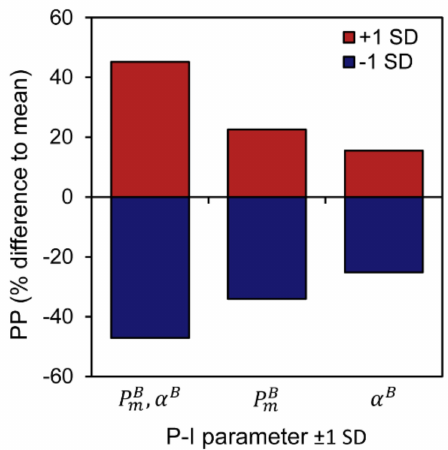
Figure 5. Percentage change in global annual primary production (PP) compared with estimates based on mean photosynthesis versus irradiance (P-I) parameters. Results from three different sensitivity analyses are given: (1) both the initial slope ( α B ) and assimilation number ( P B m ) of the P-I curve were adjusted by 1 standard deviation (SD) [ P B m , α B ]; (2) only P B m was adjusted by 1 standard deviation [ P B m ]; and (3) only α B was adjusted by 1 standard deviation [ α B ].